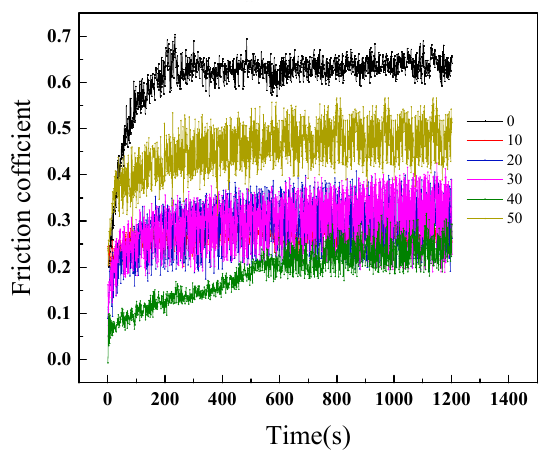
Figure 8. The friction coefficient of the superhydrophobic nickel surfaces with different depth groove